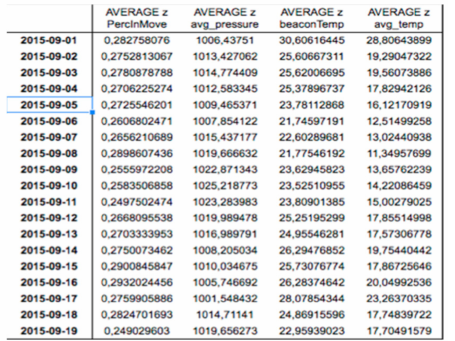
Figure 6. Aggregates resulting from query of data